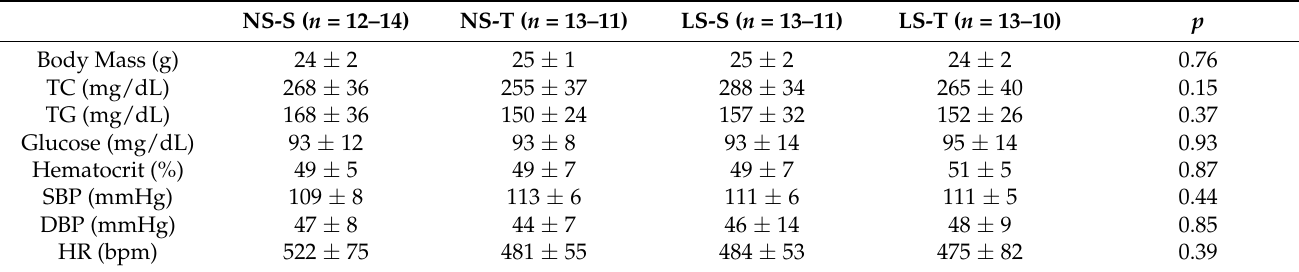
Table 1. Characterization of groups before intervention.